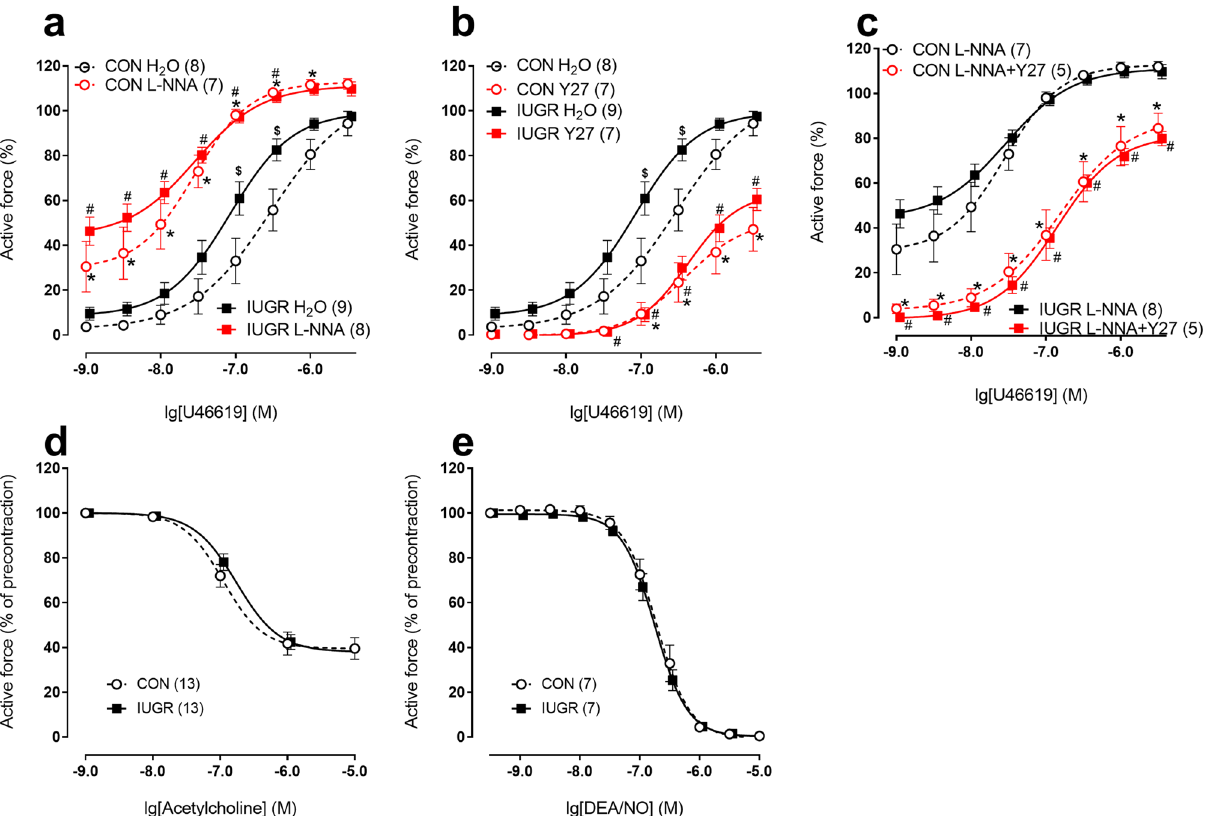
Figure 4. IUGR leads to the increase of contractile responses of adult offspring coronary arteries due to reduction of anticontractile influence of NO. ( a – c ) Concentration–response relationships to U46619 of coronary arteries from control and IUGR groups in the presence of vehicle (H 2 O) or 100 µM NO-synthase inhibitor L-NNA ( a ), vehicle (H 2 O) or 3 µM Rho-kinase inhibitor Y27632 ( b ), 100 µM L-NNA alone or in combination with 3 µM Y27632 ( c ). ( d , e ) Concentration–response relationships to acetylcholine ( d ) and NO-donor DEA/ NO ( e ) of coronary arteries from control and IUGR groups. Data in ( e ) were obtained in the presence of 100 µM L-NNA. Numbers in parenthesis indicate the number of animals. *p < 0.05 for control group vs. H 2 O ( a , b ) or vs. L-NNA ( c ). # p < 0.05 for IUGR group vs. H 2 O ( a , b ) or vs. L-NNA ( c ). $ p < 0.05 for control vs. IUGR group under respective conditions (two-way